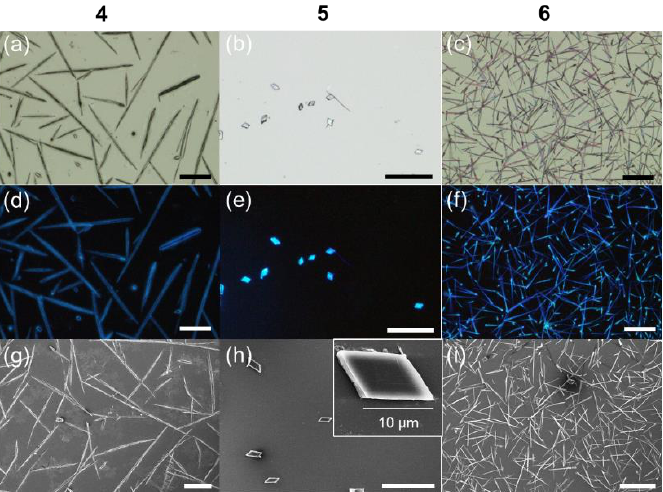
Figure 5. ( a – c ) Bright-field and ( d – f ) fluorescent microscopy images and ( g – i ) SEM images of the microcrystals of ( a , d , g ) 4 , ( b , e , h ) 5 , and ( c , f , i ) 6 . The fluorescent microscopy images were captured under the illumination of UV band (330–385 nm) of a mercury lamp. The inset of panel ( h ) shows an enlarged crystal. Scale bars are 50 µ m unless otherwise noted.